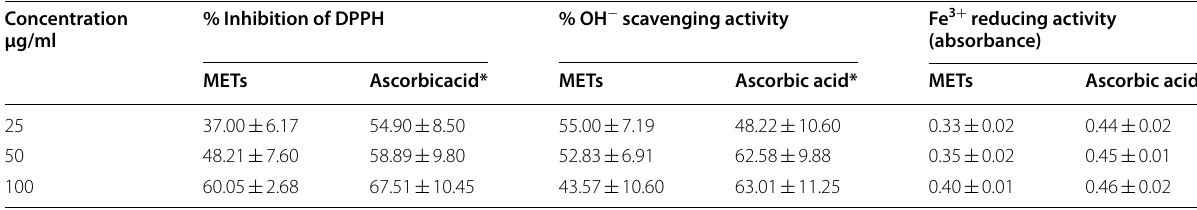
Table 4 Effect of METS on In vitro antioxidant activities: DPPH scavenging assay (%), percentage hydroxyl ion (OH • ) scavenging assay, and ferric reducing antioxidant power (FRAP)